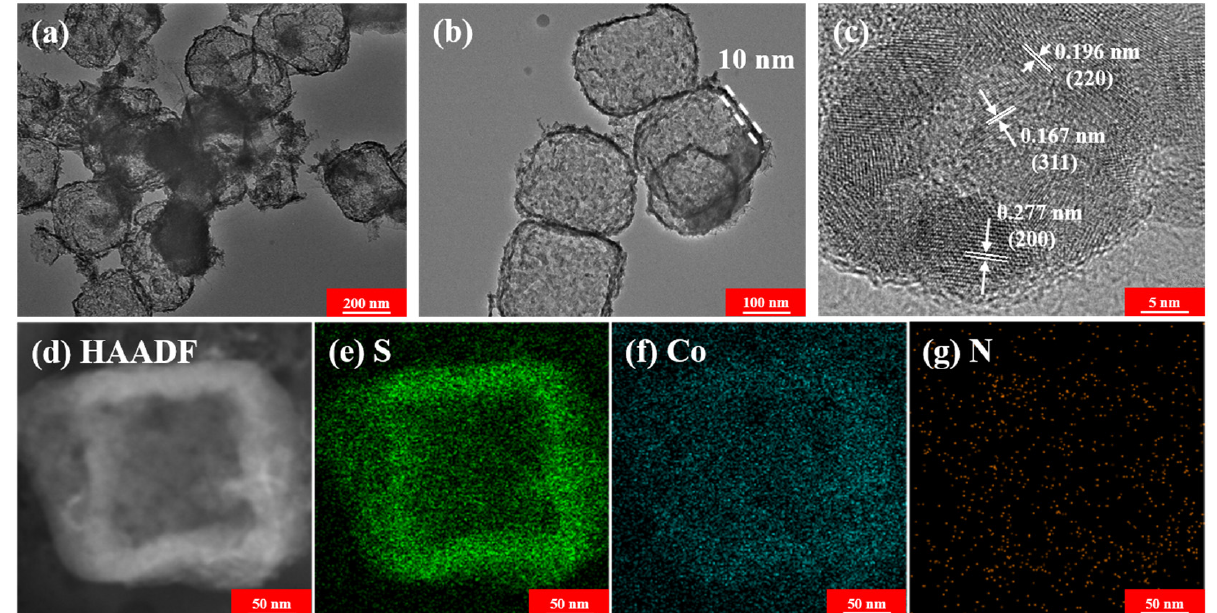
2 hollow nanoboxes ( c ).